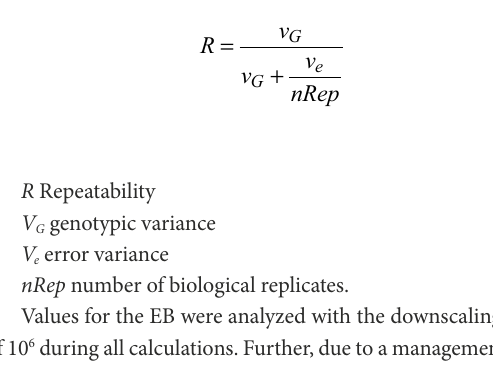
TABLE 2 Non-imaging traits measured before and at maturity. Traits measured before maturity